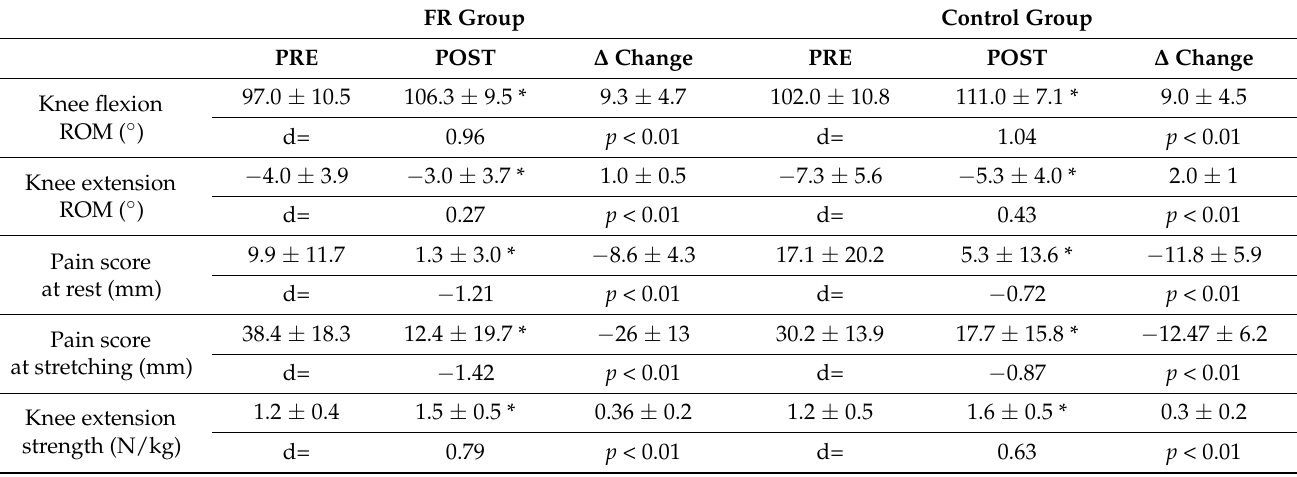
Table 1. Changes in outcome variables before (PRE) and after a 1-week comprehensive foam rolling (FR) program